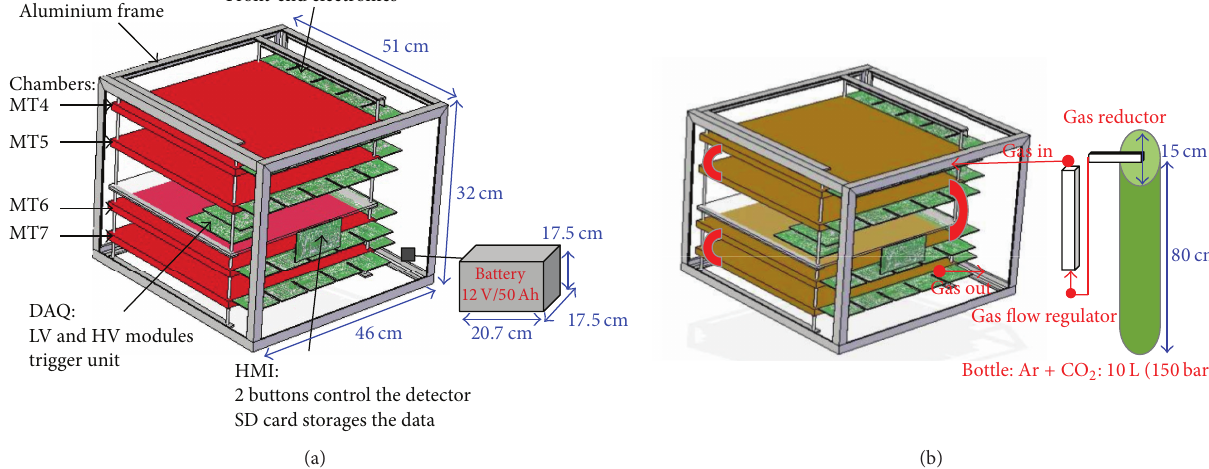
Figure 1: The layout and structure of the REGARD Muontomograph, including the power supply (a) and the gas system (b) based on [5,